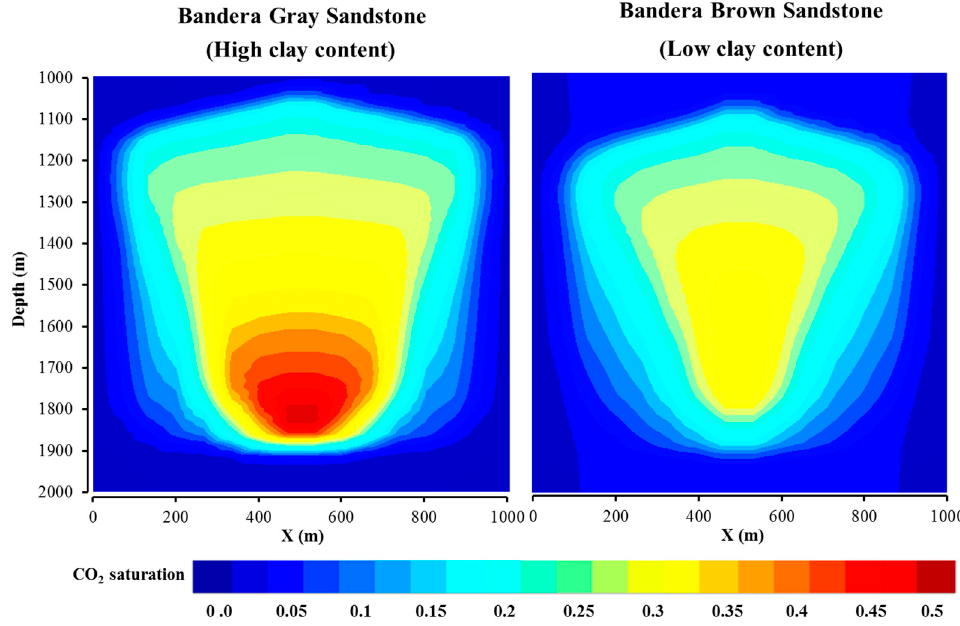
Figure 7. Free CO 2 plume behavior for the high and low clay-content sandstones at the end of injection time, showing that CO 2 remains in the gas phase and rises over time to the top of the model.